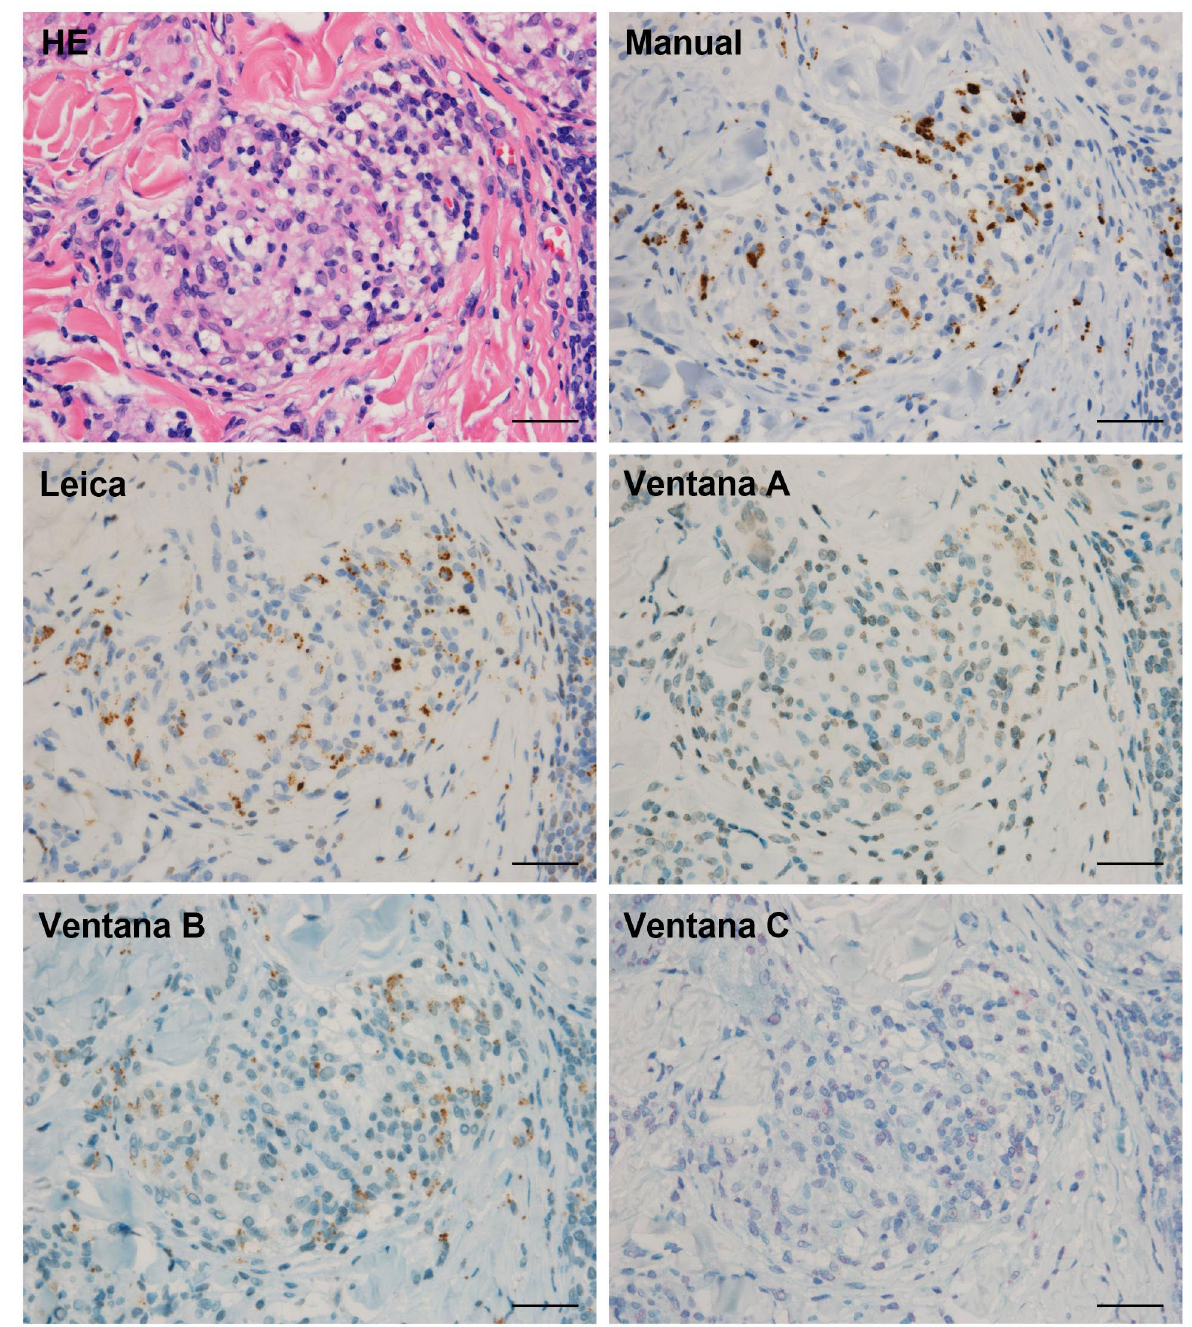
Figure 5. Representative detection status of P. acnes in sarcoid granulomas by immunohistochemistry using the manual and automated methods. The results from a skin biopsy sample with many P. acnes detected in sarcoid granulomas are presented. HE: Hematoxylin–eosin staining, Manual, Leica, Ventana A, B, C: as described in Figure 4. Almost identical localization of P. acnes -specific monoclonal antibody reactivity was observed between the manual method and the automated method using the Leica system, although the intensity of the positive signals in the automated system was generally lower than that in the manual method. Scale bar: 50 μm.